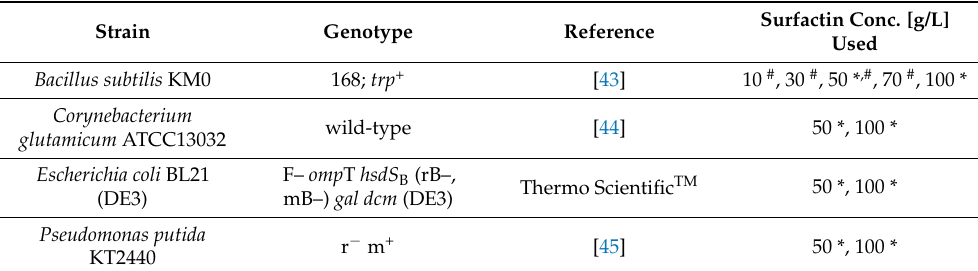
Surfactin Conc. [g/L] Used